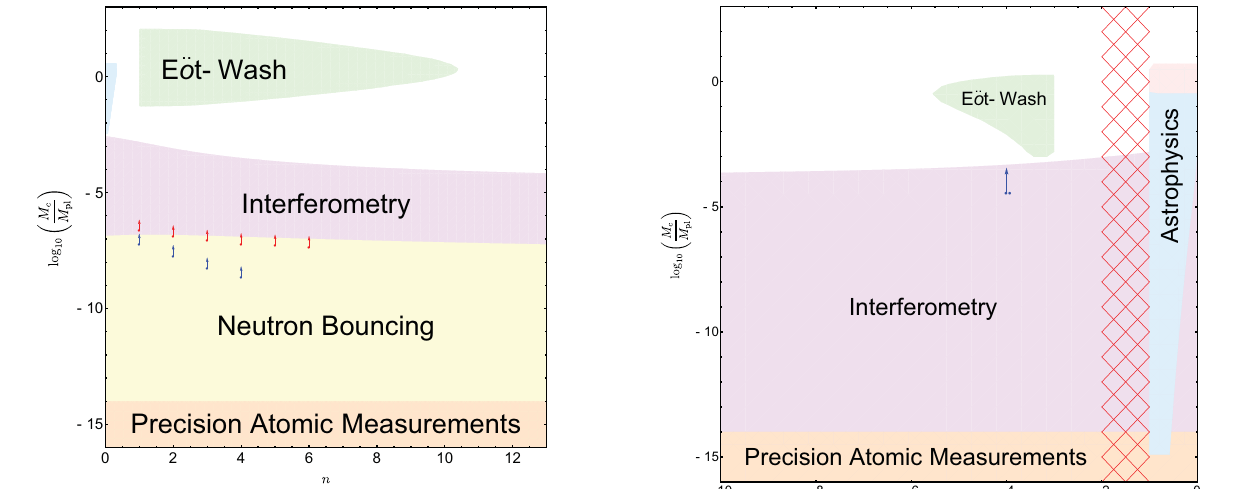
Figure 1. Current bounds on the parameters n and M c when (cid:8) is fixed to the dark energy scale and n > 0. The coloured regions are excluded. The blue region corresponds to astrophysical tests, which includes both Cepheid and rotation curve tests. The purple region, labeled interferometry, shows the constraints from atom interferometry. The blue and red arrows indicate the lower bounds coming from the neutron interferometry experiments of [33] and [32] respectively. This figure first appeared in [42].